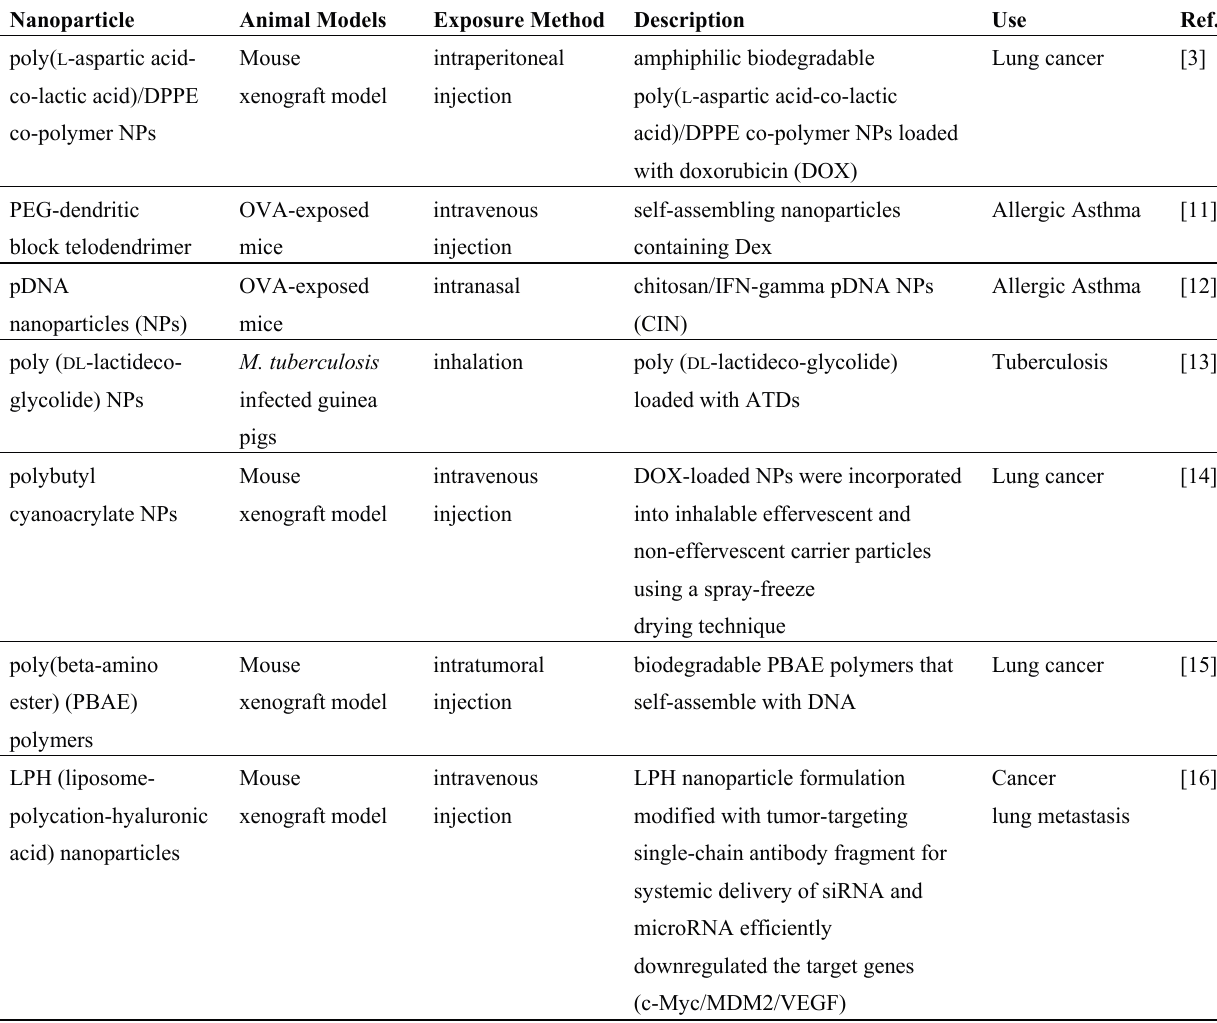
Table 1. Nanoparticles used for respiratory